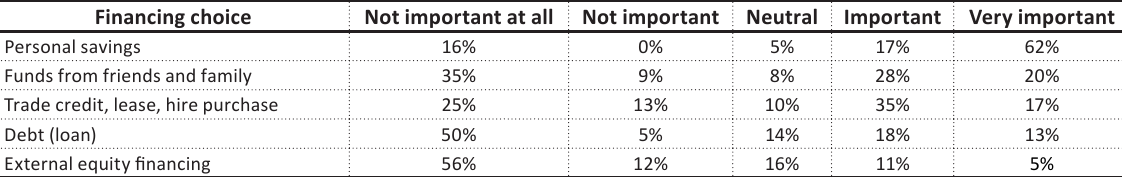
Table 4. Initial financing choice of